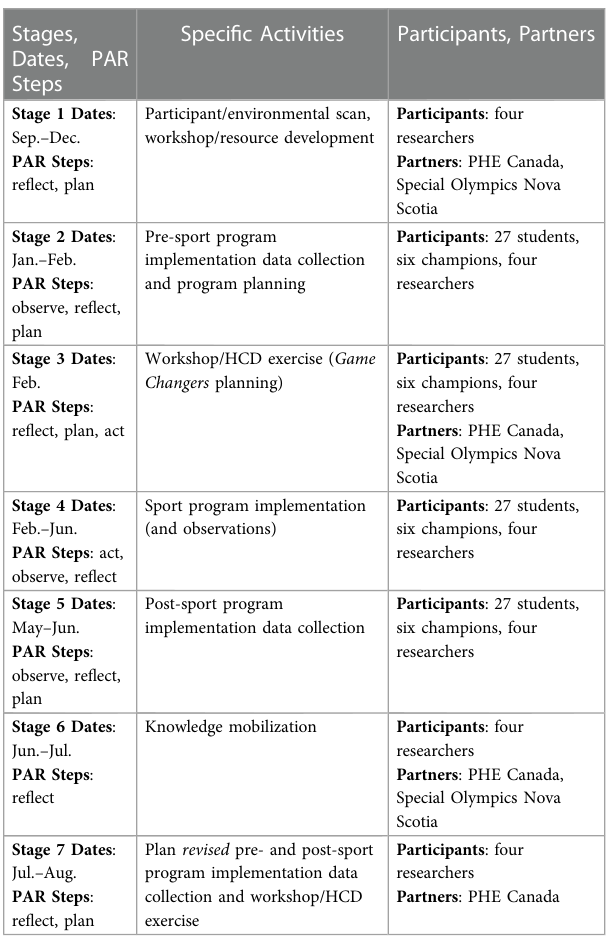
TABLE 1 Overview of stages, dates, participatory action research (PAR) steps, speci fi c activities, and participants and